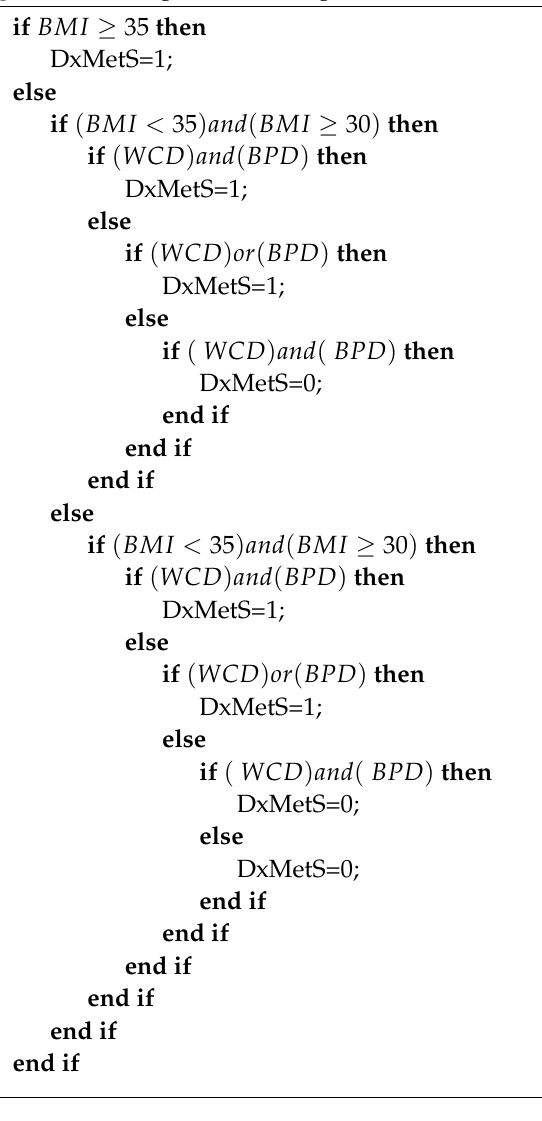
Algorithm A3 Algorithm to diagnostic MetS risk with ATP III criteria using the decision tree